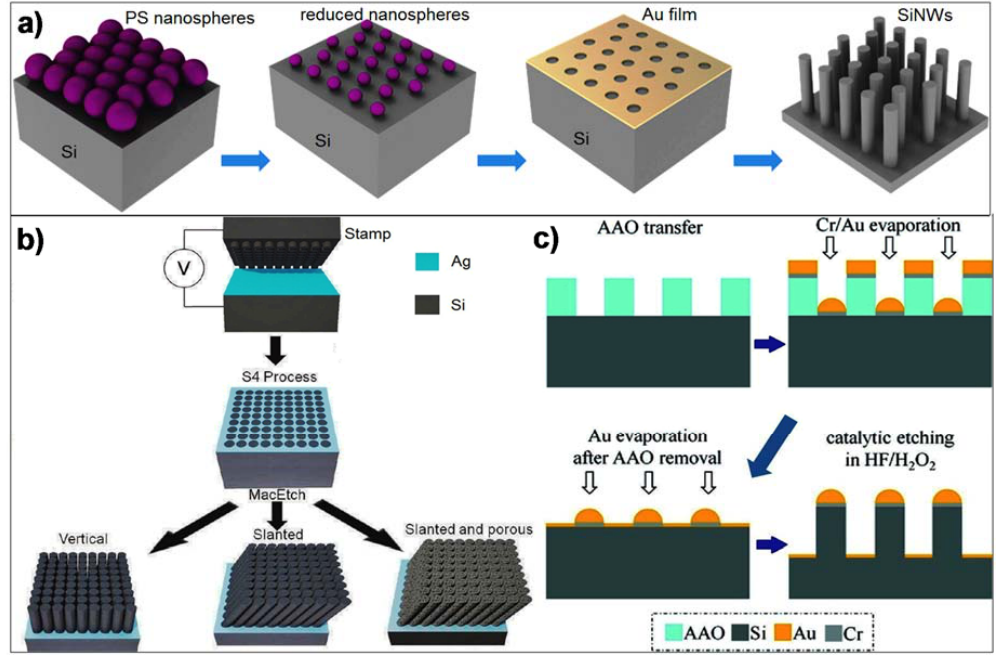
Figure 2. ( a ) Schematic of a typical vertical SiNWs’ fabrication process based on blocking ‐ dots patterning. Polystyrene (PS) nanospheres are deposited on Si wafer, followed by gold (Au) deposition. The resulting Au mesh serves as catalytic mask in the etchant solution (e.g., H 2 O/HF/H 2 O 2 ) to define the SiNWs, Reprinted with permission from Ref. [34], Copyright (2011), IOP. ( b ) Vertical SiNWs fabrication by ionic solid ‐ state molding. SiNW pattern is transferred from an Ag 2 S stamp onto an Ag coated Si wafer by applying a potential. Such pattern is used for catalytic wet ‐ etching to form the SiNW, Reprinted with permission from Ref. [39], Copyright (2010), ACS. ( c ) Fabrication of vertical SiNWs by anodized aluminum oxide (AAO) molding. An AAO mold with desired pore diameters is used as a shadow mask for patterning of Au/Cr blocking ‐ dots, which later will be used to define SiNWs through a catalytic wet ‐ etching. Reprinted with permission from Ref. [33], Copyright (2010),